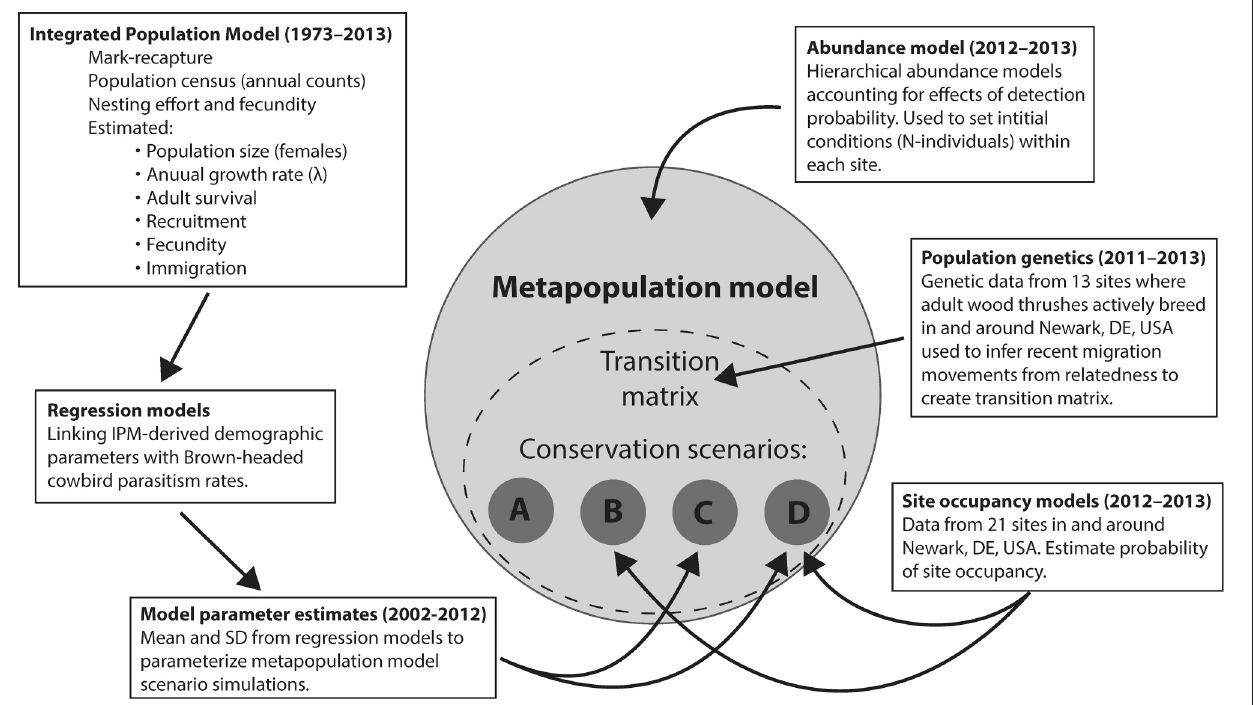
FIGURE 1 | Conceptual diagram depicting data inputs (years shown in parentheses), analyses, and various modeling approaches used in parameterizing metapopulation model framework for comparison among conservation scenarios: (A) Null, (B) Reforest, (C) Cowbird removal, and (D) Reforest and Cowbird